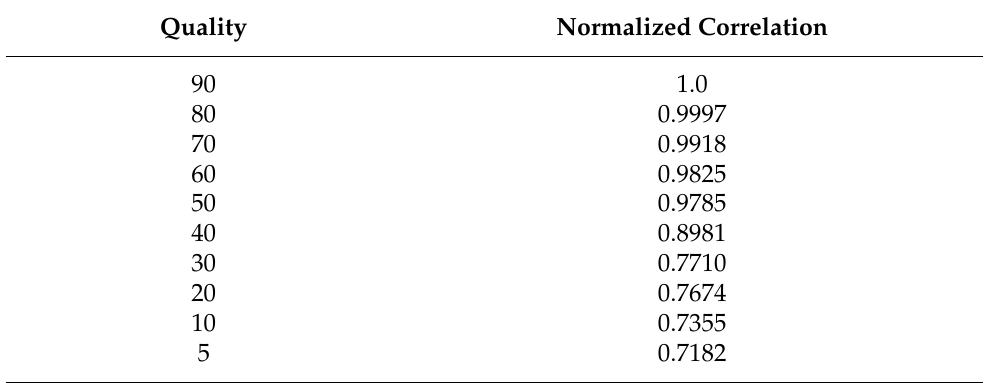
Table 6. Watermark robustness in terms of NC after JPEG compression for 30 test images.